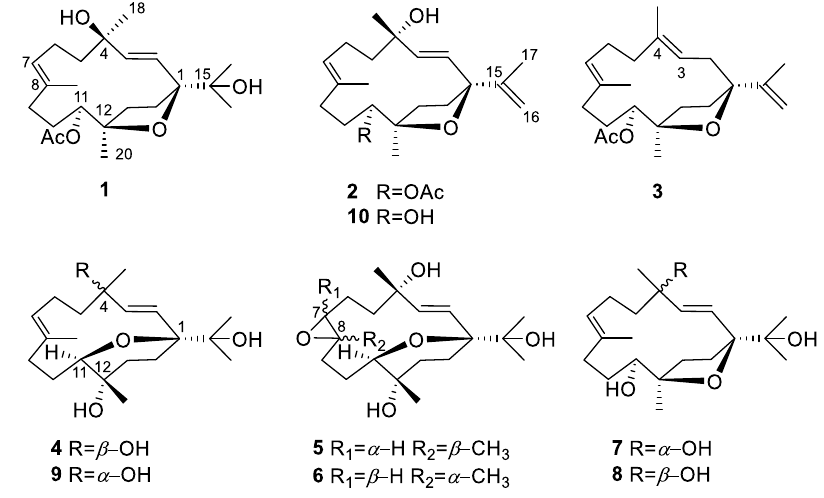
Figure 1. Structures of compounds 1 – 10 .